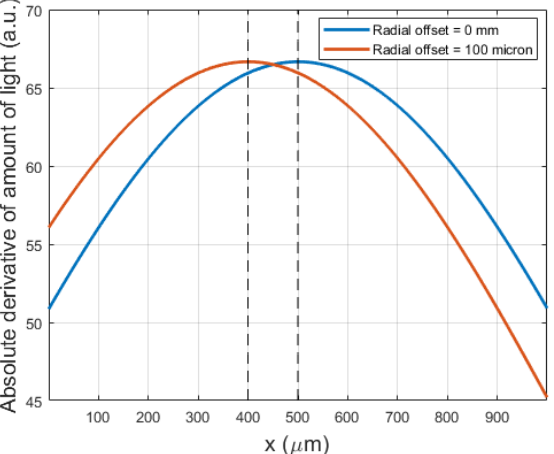
Figure 13. Simulation results of a radial offset, confirming the experimental findings.